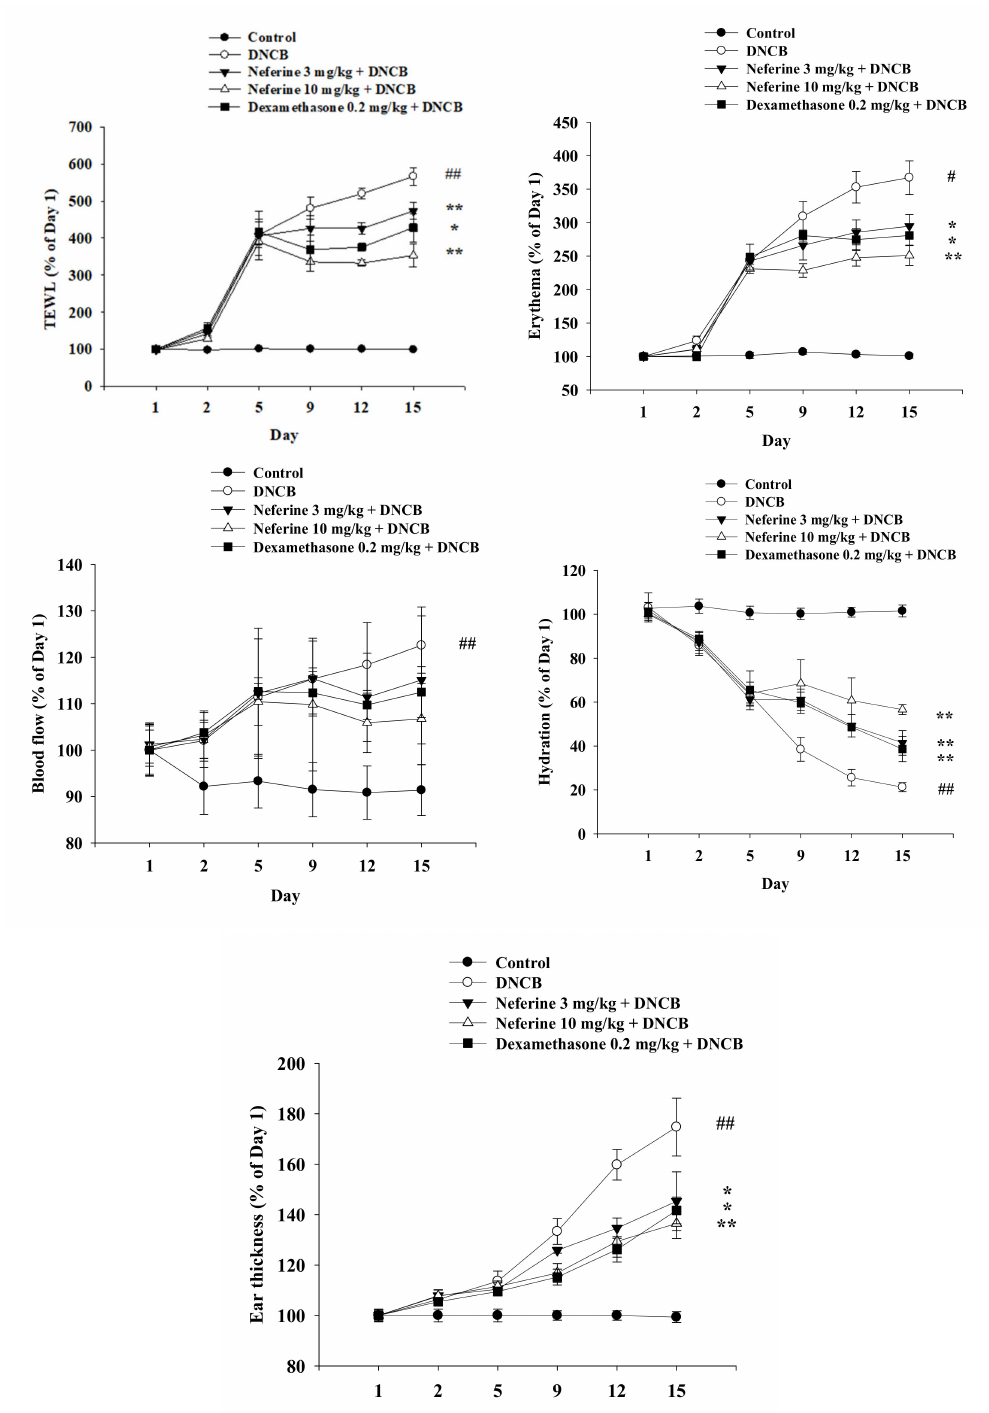
Figure 7. Change in physiological parameters of DNCB-induced BALB/c mouse skin after treatment with neferine. Analysis of the effect of the change in trans-epidermal water loss (TEWL), erythema, blood flow, hydration, and ear thickness in an atopic-dermatitis-like phenotype in BALB/c mice. Values represent the mean ± SEM from at least six independent experiments. # p < 0.05; ## p < 0.01 compared with the no-treatment condition; * p < 0.05 and ** p < 0.01 compared with the DNCB-induced